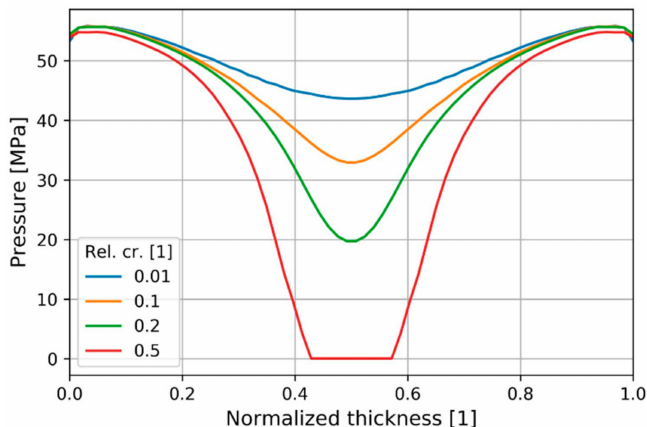
Figure 15. Pressure distribution through normalized thickness depending on relative crystallinity at